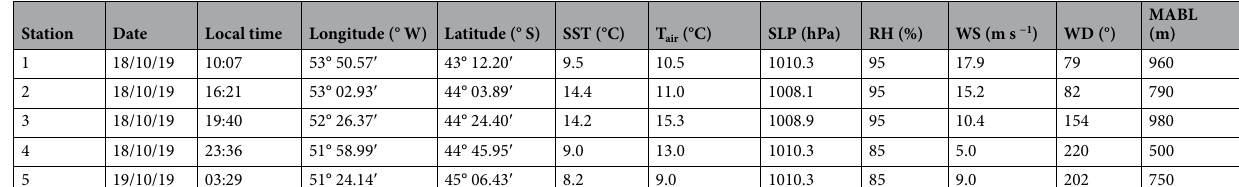
Table 1. Radiosonde date, time and position of launching. Sea surface temperature (SST), air temperature (T air ), sea level pressure (SLP), relative humidity (RH), wind speed (WS), direction (WD). T air and SLP were measured by ship’s automatic weather station (AWS). SST that was obtained by the ship’s thermosalinographer and MABL top height that was estimated from radiosondes